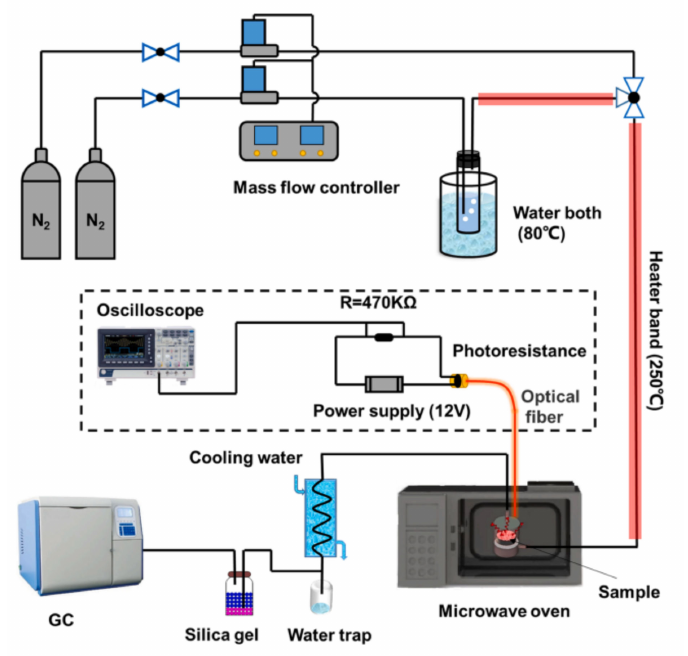
Figure 9. Schematic representation for performing the thermochemical water splitting cycle using (FeMgCoNi)O x supported on silicon carbide foam using a microwave oven. Reprinted from